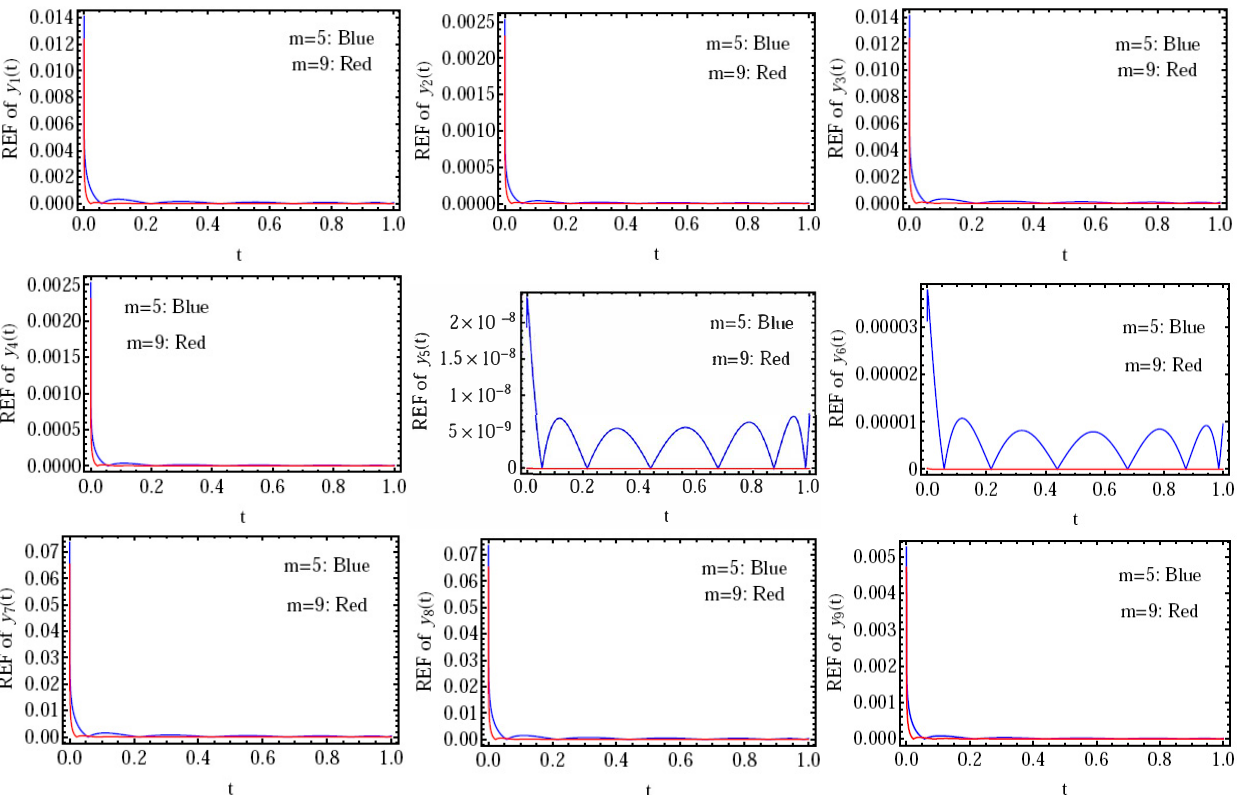
Figure 4. The REF of y i ( t ) , i = 1 ( 1 ) 9 against distinct values of m